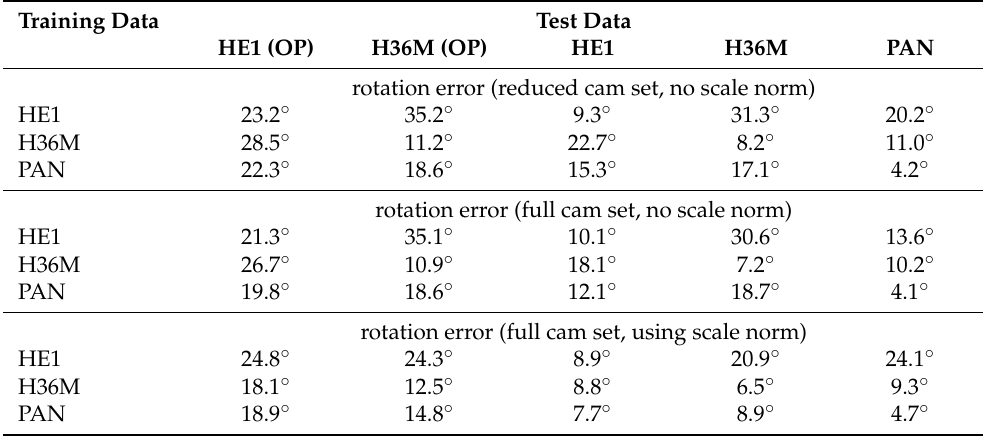
Table 13. Mean rotation corrections of the Procrustes alignment for different camera sets and scale